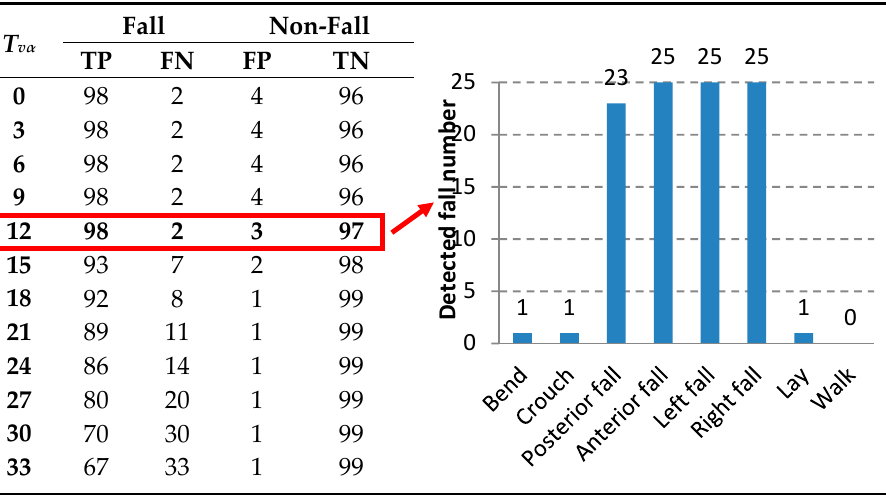
Figure 10. The duration of each fall in the self-collected dataset. There are in total 100 fall videos in the dataset. Eleven groups of experiments were tested on the self-collected dataset with different T v α to find out its best default value. According to the results, when T v α was set 12 degree/100 ms, a fall can be detected in the middle of the activity; while a fall may not be detected if T v α was set too large, and false alarm rate increases when T v α was set too small. Table 1 shows the test results on our self-collected dataset with different values of T v α . Table 1. The test results on the self-collected dataset with different T v α . TP: true positive; FN: false negative; FP: false positive; TN: true negative.